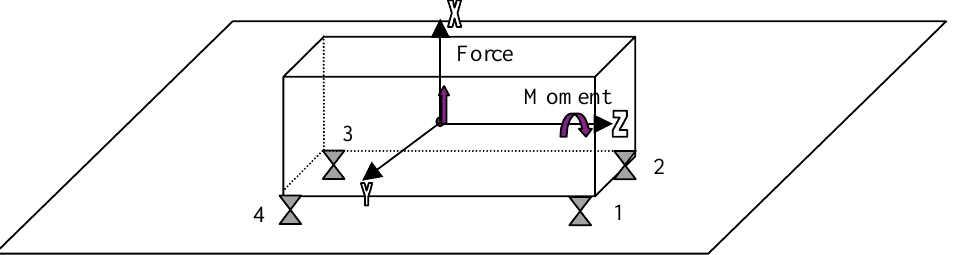
Fig. 1. Rigid body installed with compliant mounts on the flexible foundation. The origin of global co-ordinate system is at the centre of gravity of rigid body. Y and Z axes are parallel to the base and X -axis is normal to the